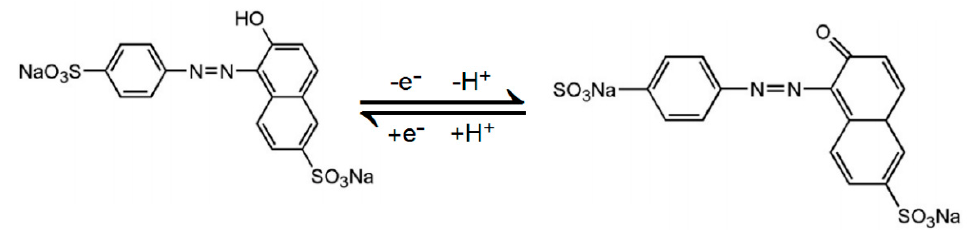
Figure 6. Effects of pH on the current response and potential response of 10 μ M SY. Accumulation potential: 0.1 V, accumulation time: 180 s, scan rate 0.1 V/s.